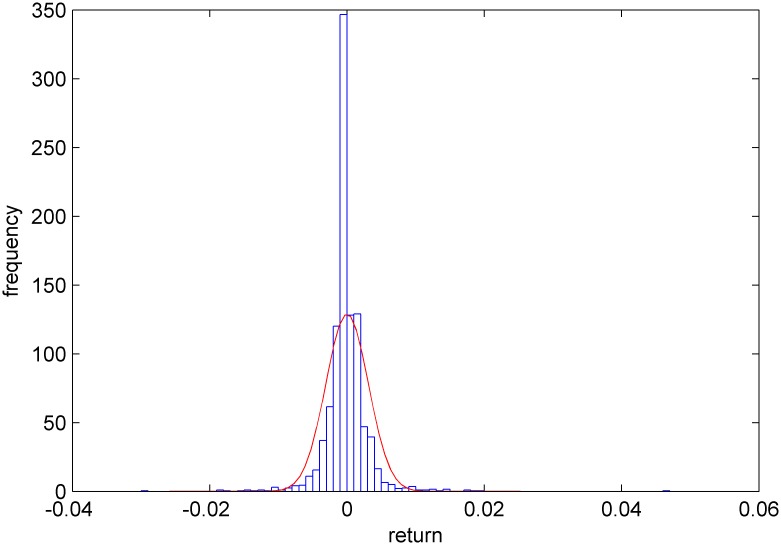
The yield distribution fitting diagram of CDA.